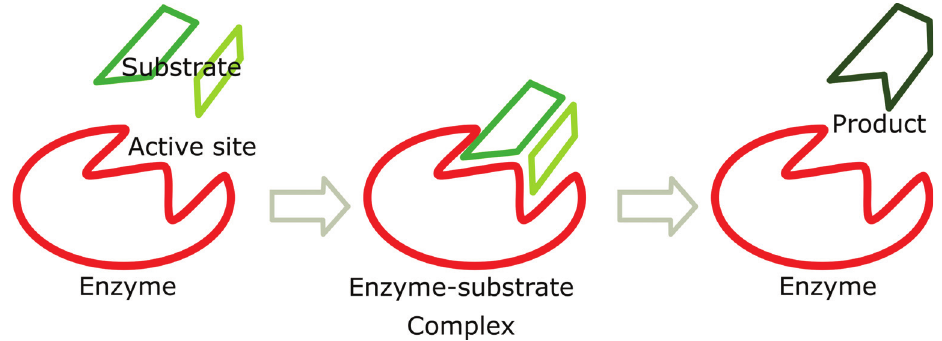
Figure1 -Hypotheticalschemeofanenzymaticreaction.Pointmutationsinthegeneencodinganenzymemayalteritsenzymaticactivityleadingtosub- strate accumulation and a lack of product. In addition, it may also cause the accumulated substrate to follow an alternative route. This is the cause of many